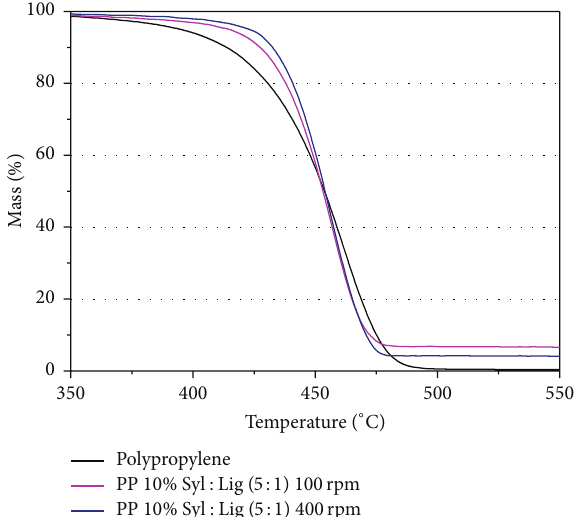
Figure 9: Tensile strength obtained during static uniaxial deforma- tion versus applied screw speed.